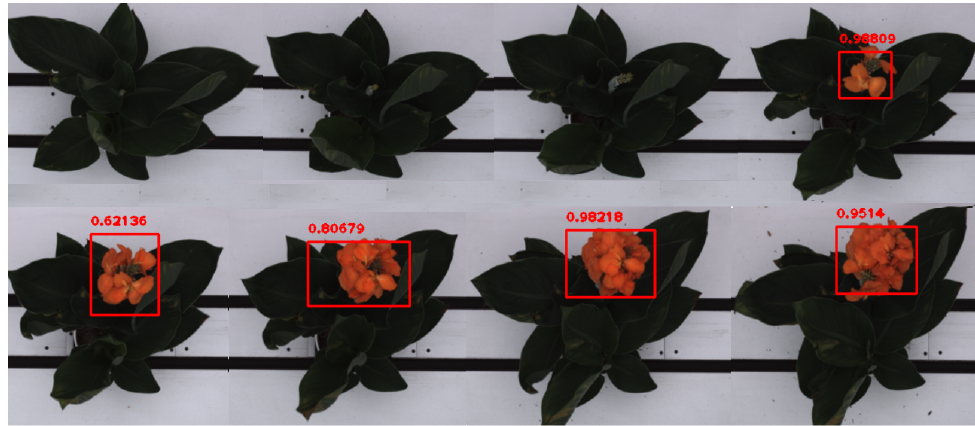
Figure 13. Illustration of flower emergence timing detection and its growth over consecutive days (following left to right direction) using a sample canna image sequence (D2) for the top view starting from Day 28 ( top-left ) to Day 35 ( bottom-right